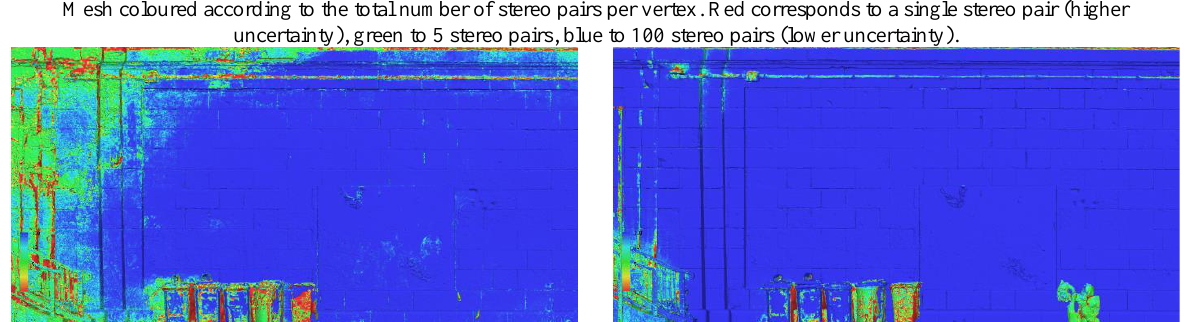
Mesh coloured according to the total number of stereo pairs per vertex. Red corresponds to a single stereo pair (higher uncertainty), green to 5 stereo pairs, blue to 100 stereo pairs (lower uncertainty).